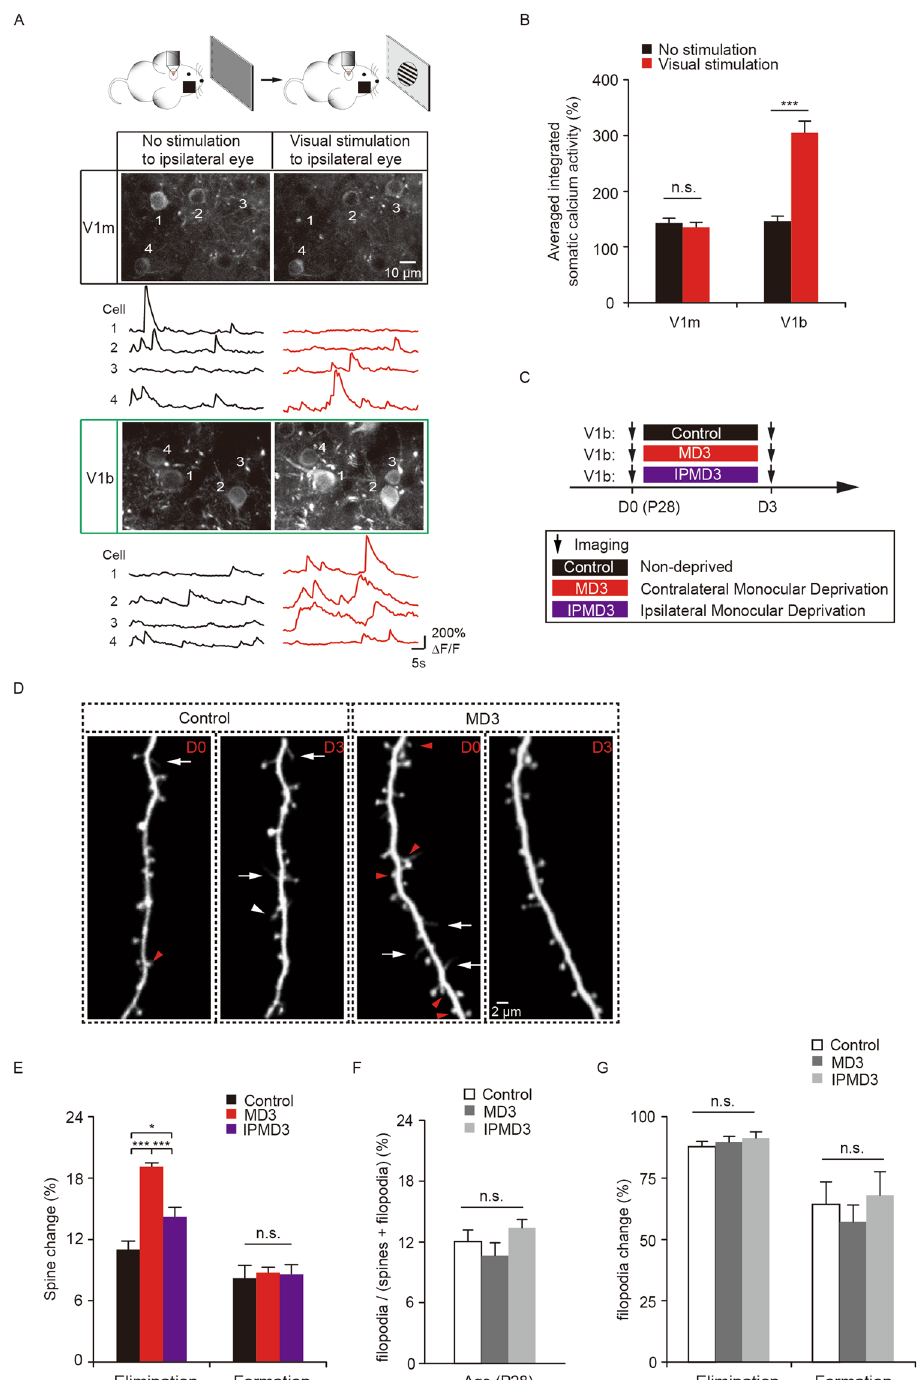
Figure 1. MD increases dendritic spine elimination in the binocular region during the critical period. ( A ) Two- photon calcium imaging of layer 2/3 pyramidal neurons in the monocular (V1m) and binocular (V1b) regions of the visual cortex in mice with the contralateral eye covered. Scale bar: 10 μ m. Black traces represent activities without visual stimulation. Red traces represent activities when visual stimulus was presented to the ipsilateral eye. Calcium fluorescence traces of four neurons over 50 s are shown. ( B ) Somatic calcium activities in V1m were comparable between no stimulation and stimulation conditions (n = 4 mice, 205 cells). Somatic calcium activities in V1b were significantly increased when visual stimulus was presented to the ipsilateral eye (n = 3 mice, 179 cells). ( C ) Schematic of experimental paradigm. MD represents deprivation of the contralateral eye relative to the imaged hemisphere. IPMD represents deprivation of the ipsilateral eye. ( D ) Images of dendritic spines on apical tuft dendrites of layer 5 pyramidal neurons in control and MD mice over 3 days during the critical period. Red arrowheads indicate eliminated dendritic spines and white arrowhead indicates newly formed spines. White arrows indicate dendritic filopodia. Scale bar: 2 μ m. ( E ) Percentage of dendritic